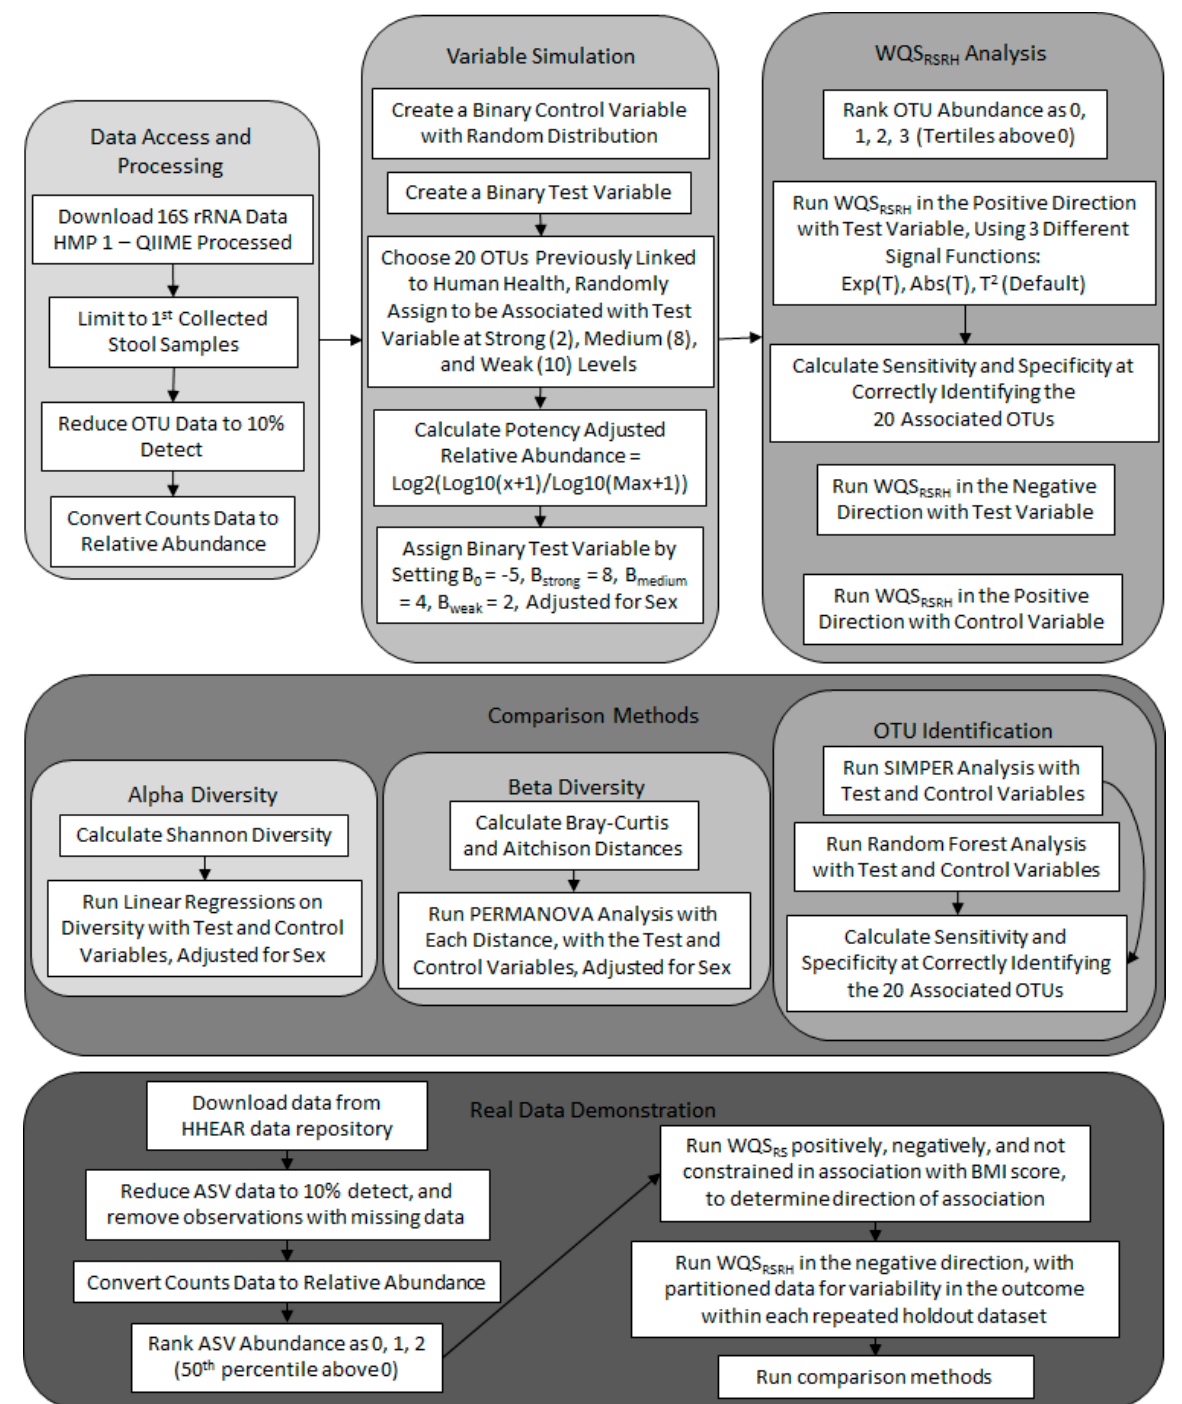
Figure 1. Study Schematic. A simplified flow-chart of the study procedures. Abbreviations: Ampli- con Sequence Variant (ASV); Body Mass Index (BMI); Human Health Exposure Analysis Resource (HHEAR); Human Microbiome Project (HMP); Operational Taxonomic Unit (OTU); Permutational Analysis of Variance (PERMANOVA); Quantitative Insights Into Microbial Ecology (QIIME); Sim- ilarity Percentage (SIMPER); Weighted Quantile Sum Regression with Random Subsets (WQS RS ); Weighted Quantile Sum Regression with Random Subsets and Repeated Holdouts (WQS RSRH